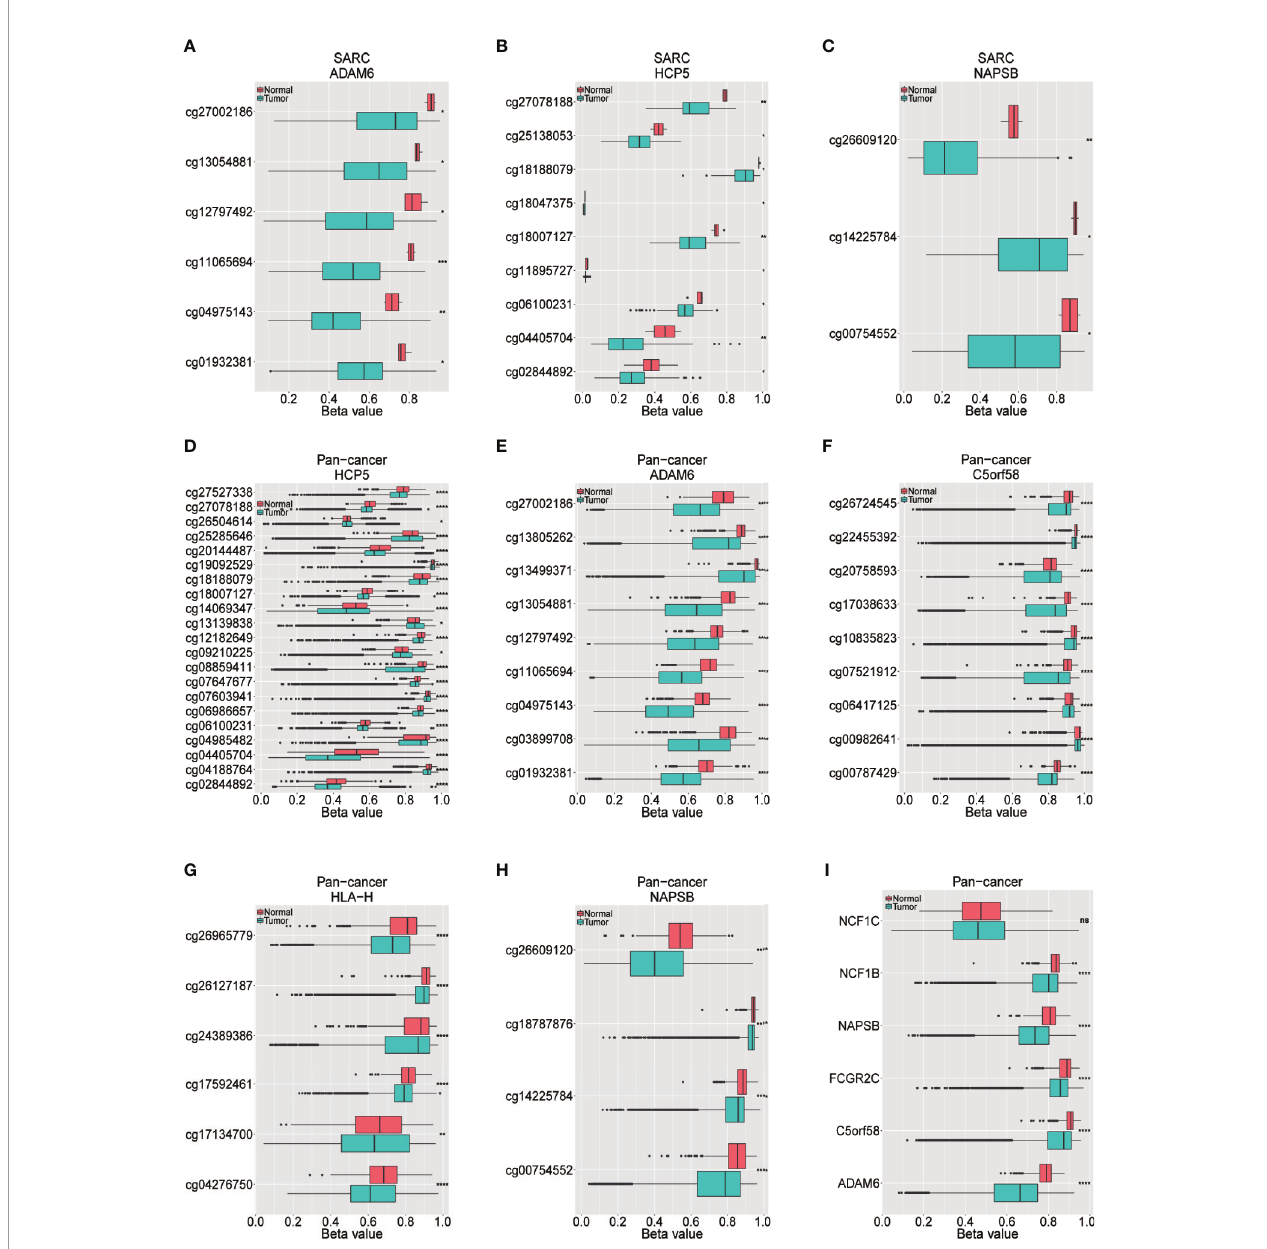
FIGURE 5 | Different methylation sites in ICLs in sarcoma and pancancer. (A – C) Different methylation sites in the ADAM6/HCP5/NAPSB/locus in sarcoma tissues and adjacent normal tissues. (D – H) Different methylation sites in the HCP5/ADAM6/C5orf58/HLA-H/NAPSB locus in pancancer tissues and adjacent normal tissues. (I) Differential methylation of lncRNAs in pancancer tissues and adjacent normal tissues. *P < 0.05; **P < 0.01; ***P < 0.001; ****P < 0.0001; NS, No signi fi